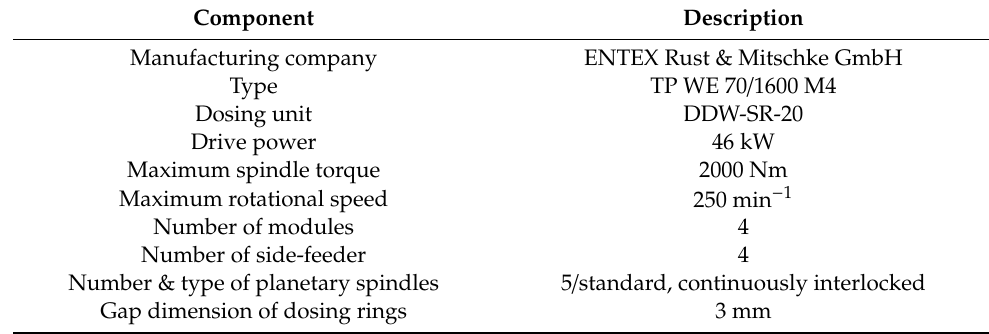
Table 8. Technical specifications of the extruder system used for the FR